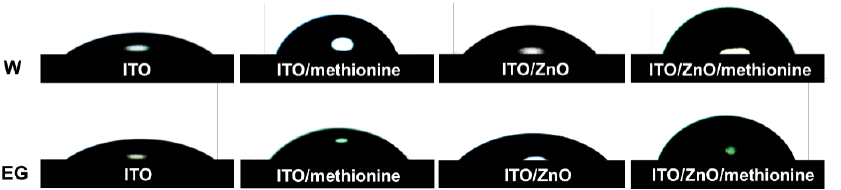
Figure 3 . ( a ) AFM height images of ITO/ETL and ( b ) ITO/ETL/active layer films. Figure 3. ( a ) AFM height images of ITO/ETL and ( b ) ITO/ETL/active layer films.